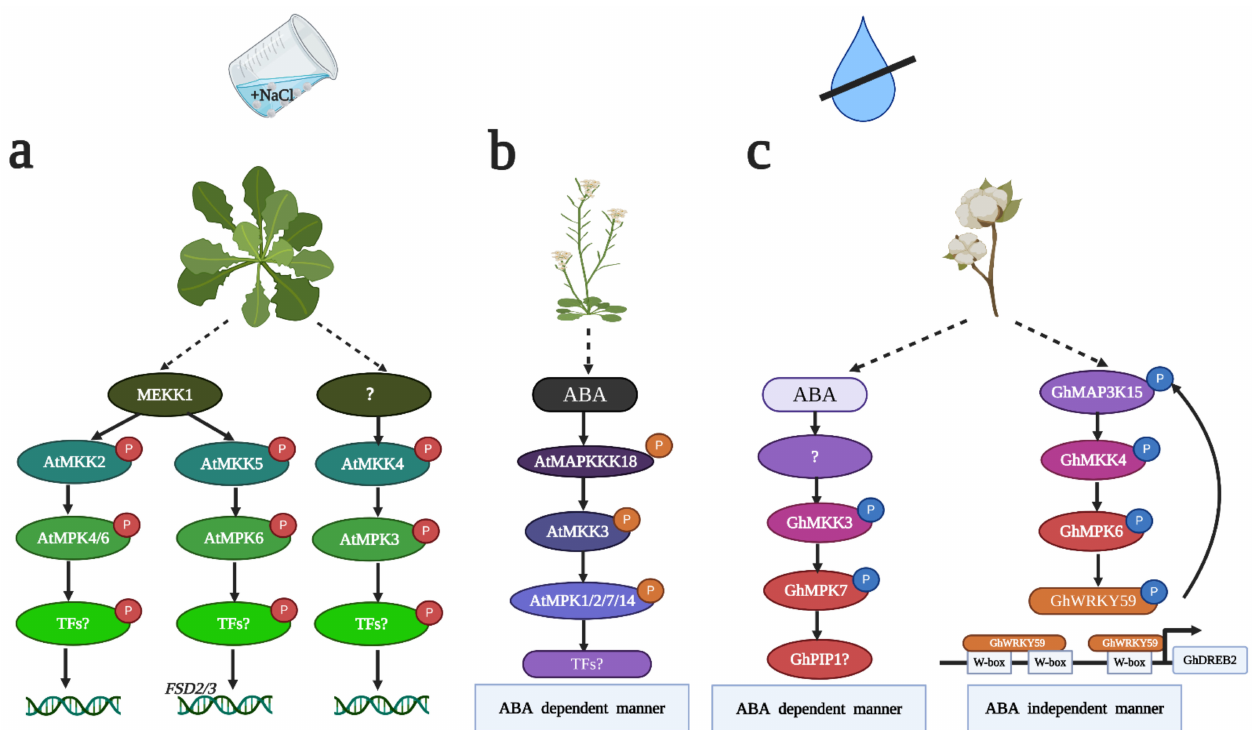
Figure 1. MAPK cascade in salt and drought stress. ( a ) The following three MAPK cascades can regulate salt stress in Arabidopsis : the AtMEKK1-AtMKK2-AtMPK4 cascade, the AtMEKK1-AtMKK5-AtMPK6 cascade and the AtMKK4-AtMPK3 cascade. The substrate of the AtMEKK1-AtMKK2-AtMPK4 and AtMKK4-AtMPK3 cascades is still unknown (marked as ?). The AtMEKK1-AtMKK5-AtMPK6 cascade confers tolerance to salt stress by regulating AtFSD2/3 expression. AtFSD2/3 are two major FSD-encoding genes in Arabidopsis . ( b ) The AtMAPKKK18-AtMKK3-AtMPK1/2/7/14 cascade can be activated by ABA after drought stress. The AtMAPKKK18-AtMKK3-AtMPK1/2/7/14 cascade positively regulates drought stress in an ABA-dependent manner. The substrate of AtMPK1/2/7/14 is unknown (marked as ?). ( c ) Two MAPK cascades are involved in drought stress in cotton. The GhMKK3-GhMPK7 cascade enhances drought tolerance in an ABA-dependent manner. Whether GhPIP1 is the substrate of GhMPK7 requires more experimental evidence (marked as ?). GhMAP3K15- GhMKK4-GhMPK6 positively regulates drought stress in an ABA-independent manner. The substrate of this cascade is GhWRKY59. GhWRKY59 can regulate GhDREB2 expression by directly binding the W-box of GhDREB2 promoters. This figure was created using BioRender (http://biorender.com/; accessed on 14 December 2020). Plants achieve tolerance to salinity by alleviating osmotic stress, which is known to induce cellular endogenous ABA concentrations [61]. It has been reported that MAPK signaling regulates salt stress in an ABA-dependent manner [62]. AtMAP3K δ 4 is an